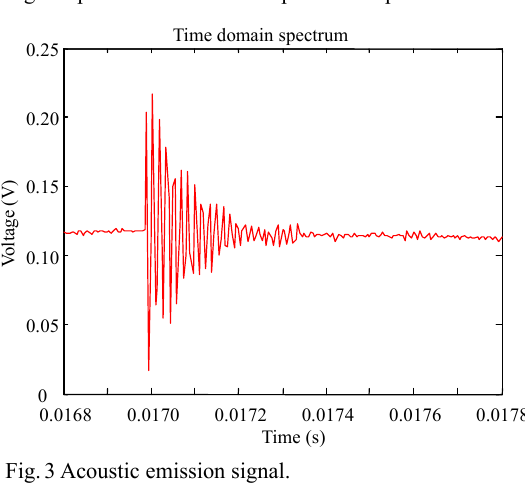
Fig. 3 Acoustic emission signal.